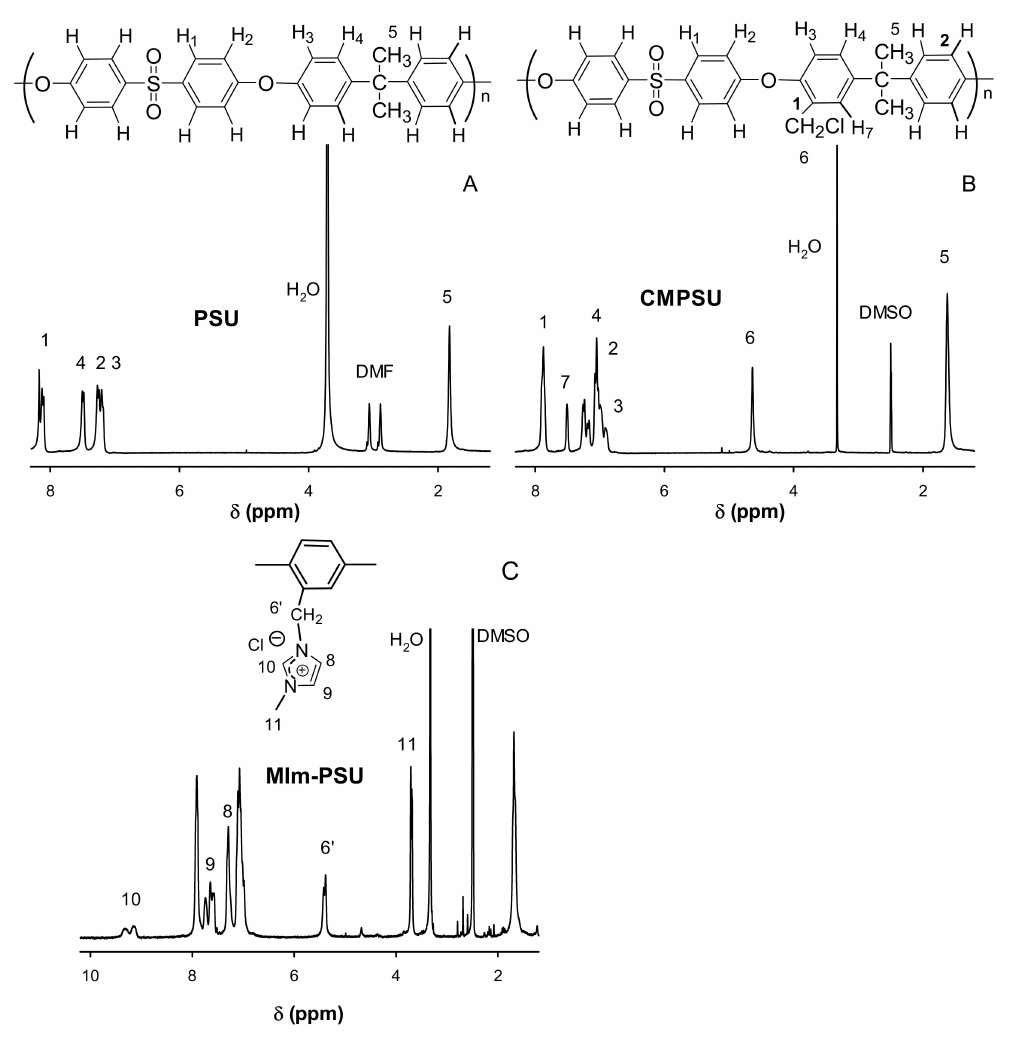
Figure A1. 1 H-NMR Spectra of PSU ( A ), CMPSU ( B ), and MIm-PSU ( C ) membranes (DMF-d 7 and DMSO-d 6